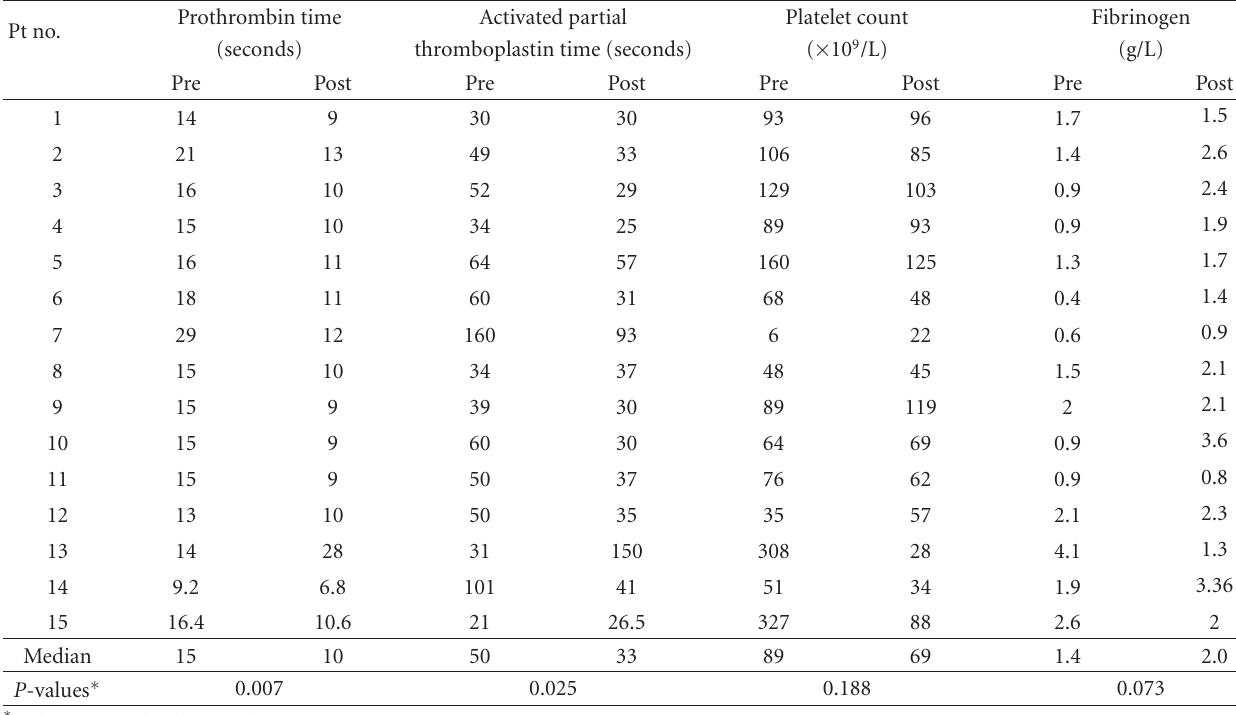
Table 3: Coagulation parameters before and after the administration of rFVIIa for major obstetric haemorrhage. Normal ranges: